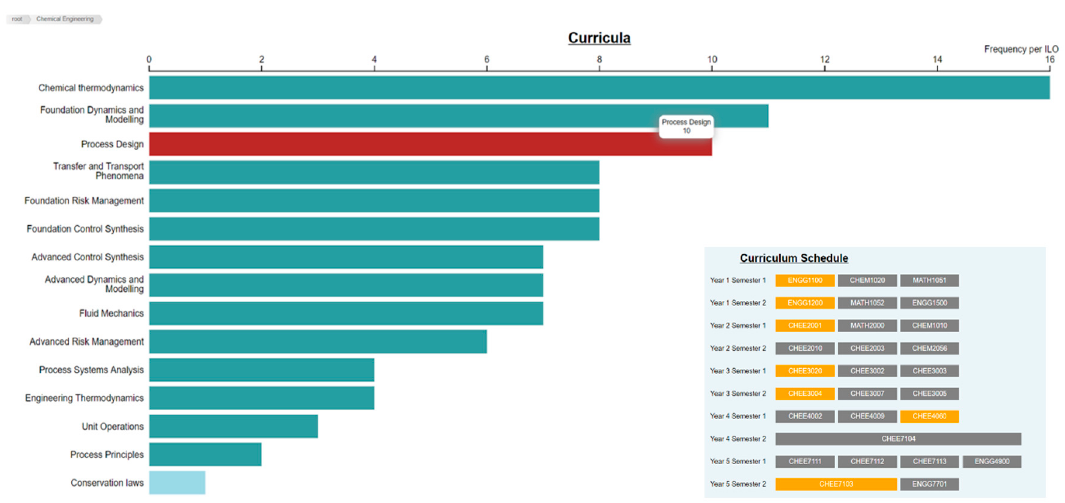
Figure 11. Lower-level domain knowledge visualization and location within the curriculum.